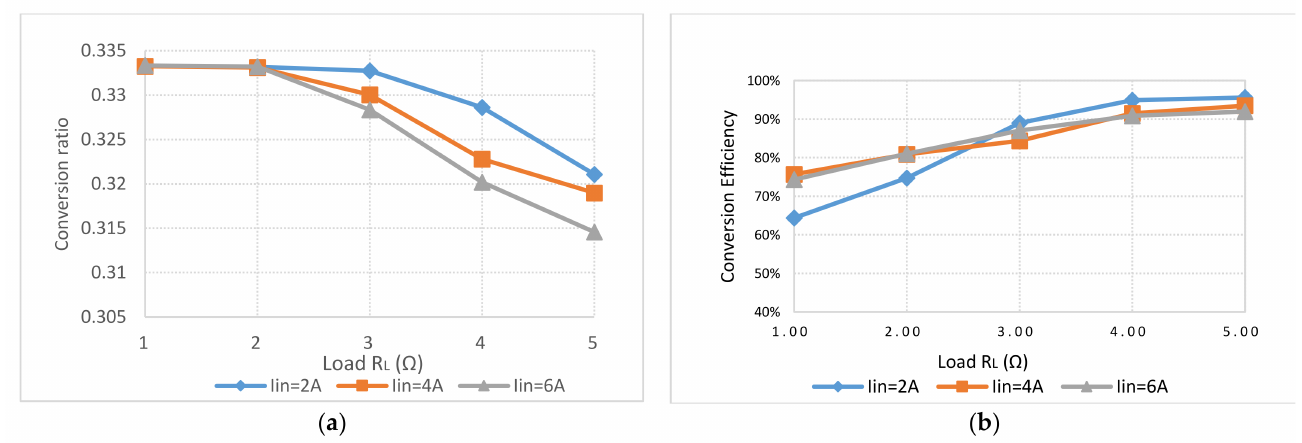
Figure 11. Experimental results of conversion ratio and efficiency of the 1/3 type proposed converter under I in = 2 A − 6 A; ( a ) current ratio against output resistance, ( b ) conversion efficiency against load.